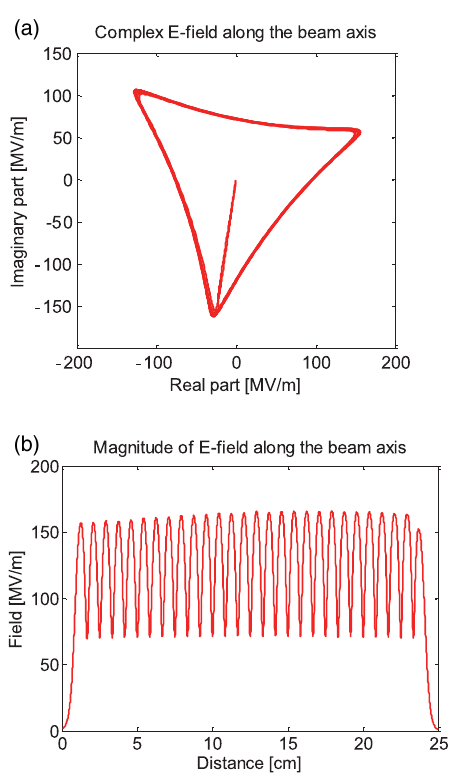
FIG. 16. Electrical accelerating field distribution on the beam axis of the new CLIC-G tapered structure: (a) in the complex plane; (b) magnitude.